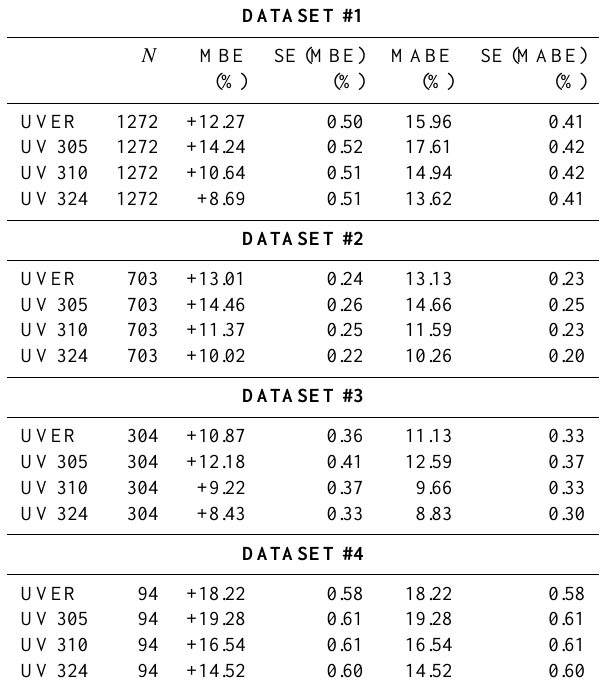
Table 2. Statistical parameters of relative differences between OMI and Brewer UV products irradiances for all sky conditions (dataset #1), cloud-free conditions (dataset #2), cloud-free cases with low aerosol load (dataset #3), and cloud-free cases with moderate-high aerosol load (dataset #4). The parameters are the following: the number of data ( N ), the mean bias error (MBE), the standard error (SE) of the MBE, the mean absolute bias error (MABE), and the SE of the